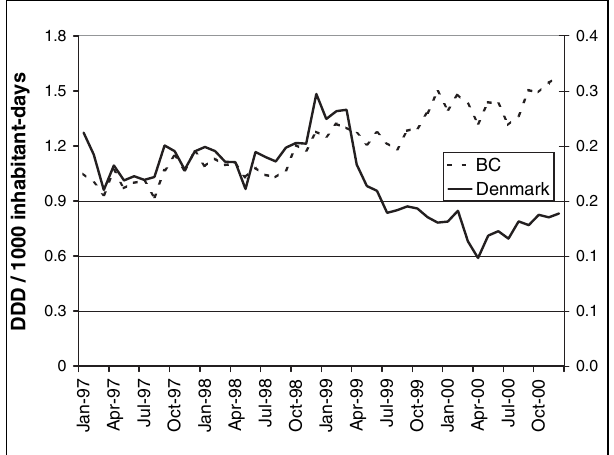
Figure 5) Comparison of rates of consumption of Class J01MA – Fluoroquinolones in British Columbia (BC) and Denmark expressed monthly from 1997 to 2000. DDD Defined Daily Dose